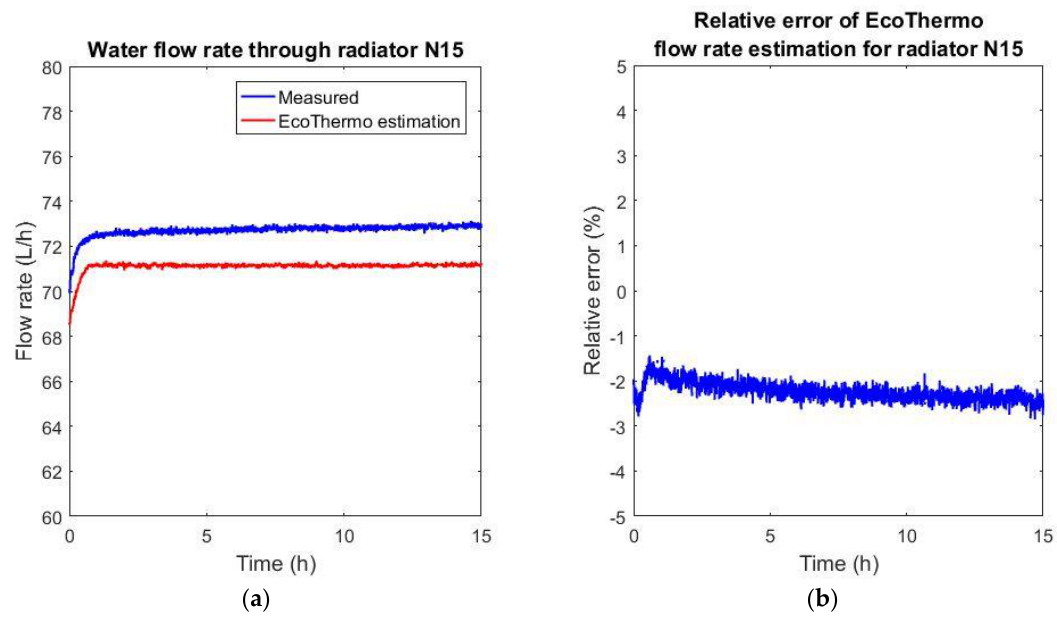
Figure 4. Time evolution of: ( a ) EcoThermo flow rate estimation and reference water flow rate measurement at a particular radiator; ( b ) corresponding relative error of EcoThermo estimation with respect to reference water flow rate measurement.